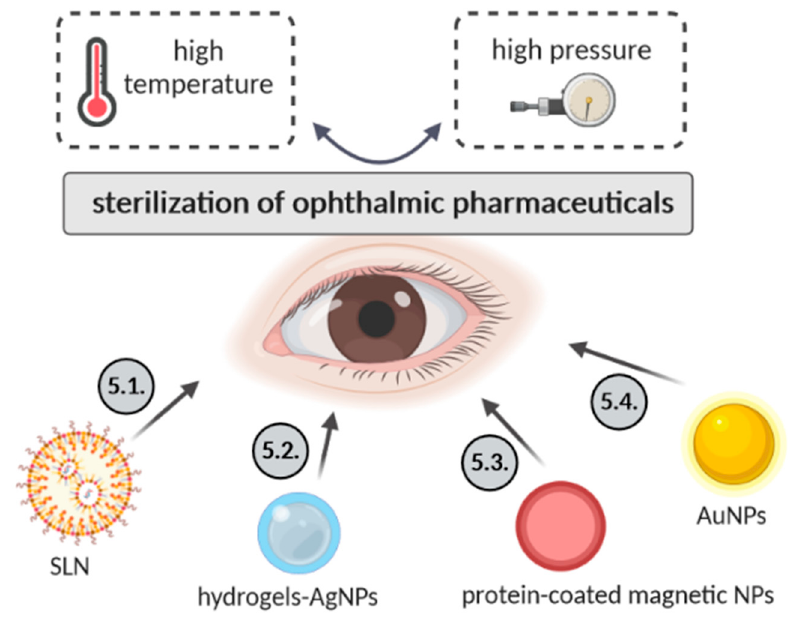
Figure 3. Different types of nanoparticles used as ophthalmic nanopharmaceuticals. Figure 3. Di ff erent types of nanoparticles used as ophthalmic